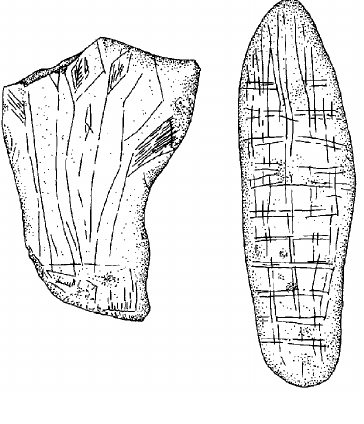
Figure 4. Engraved plaques of the Clovis layer of Gault site, Texas, of the final